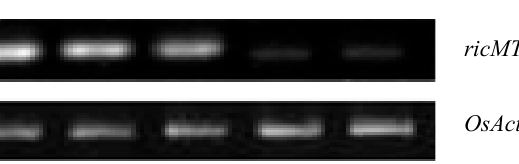
Figure 3. Generation of transgenic rice. ( a ) Diagram of the pCAMBIA1304 vectors harboring sense- ricMT ; ( b ) Diagram of the pCAMBIA1304 vectors harboring antisense- ricMT ; ( c ) Semi-quantitative RT-PCR analysis of ricMT expression in wild-type and transgenic rice suspension cells. LB represents the left border; RB represents the right border; WT represents the wild-type rice suspension cells; ricMTS1 and ricMTS2 represent two independent sense- ricMT transgenic rice suspension cell lines; ricMTA1 and ricMTA2 represent two independent antisense- ricMT rice suspension cell lines. Experiments were repeated at least three times with similar results.